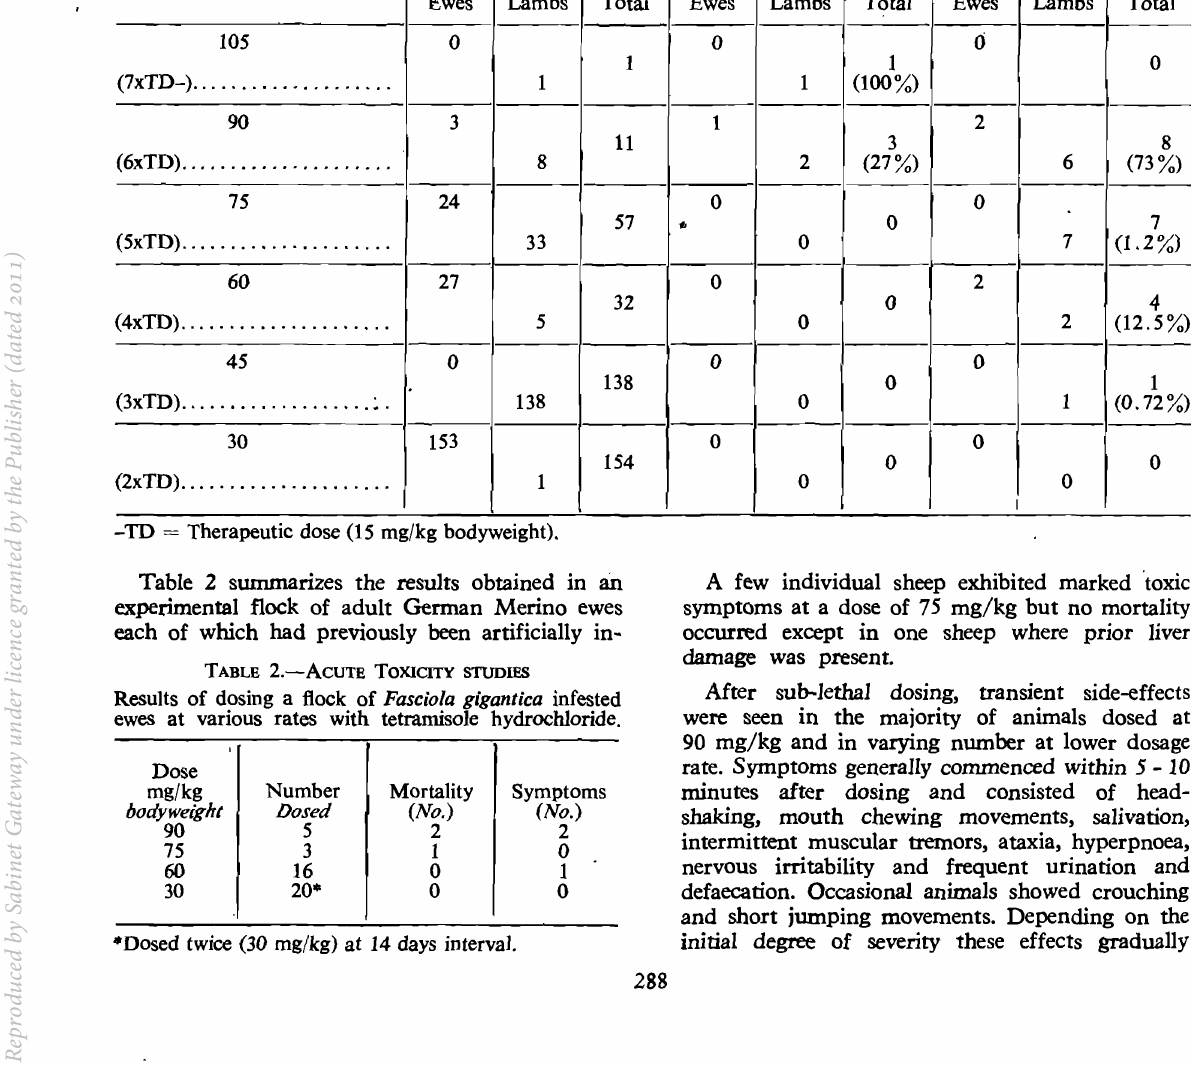
TABLE I.-AcUTE TOXICITY STUDIES. Summary of the results on the total number of sheep dosed (excluding Fasciola gigantica infested ewes) at varying rates with tetramisole hydrochloride.